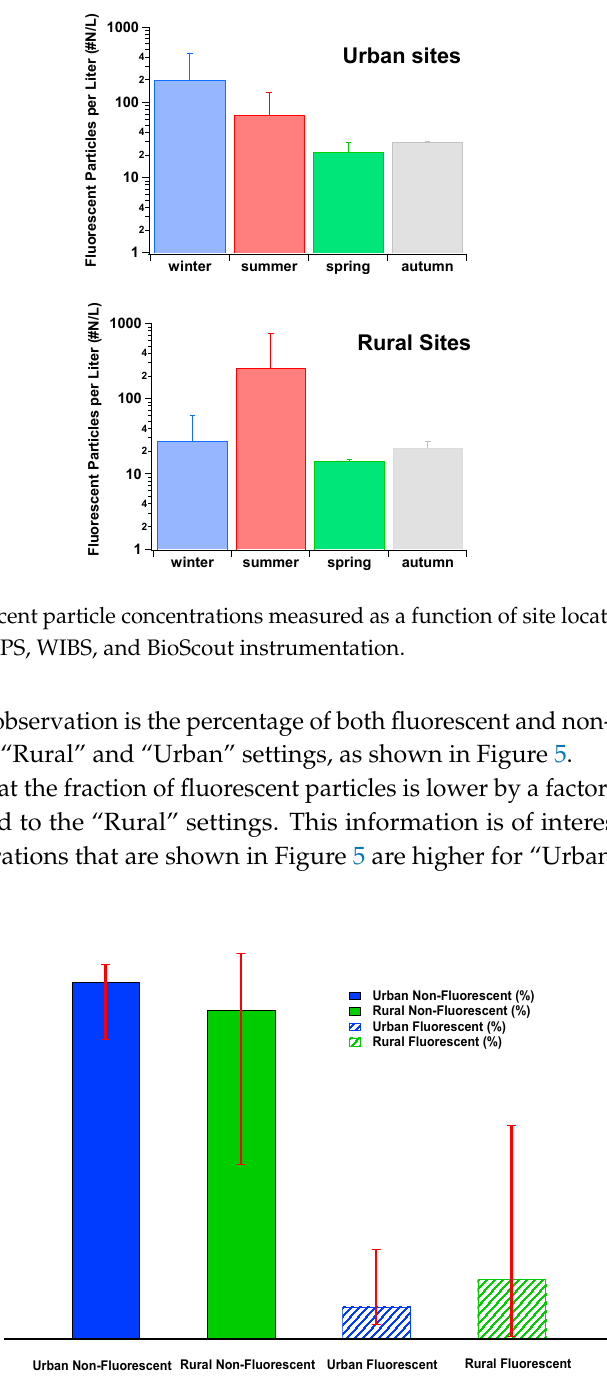
Figure 5. Fluorescent and non-fluorescent fractions of the total particle concentrations for particles >1 μ m in urban and rural locations (error bars reflect maximum and minimum values).